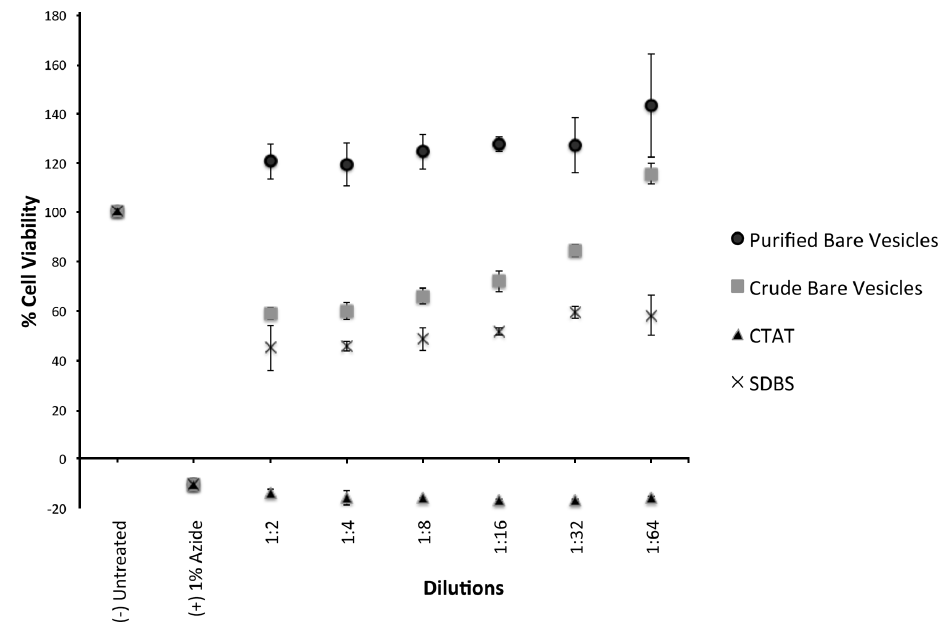
Figure 5. Cytotoxicity of CVs and components. Aliquots of vesicles or their components were incubated with THP-1 cells for 24 h and the viability assessed using an Alamar Blue assay from Biorad. 1% sodium azide was used as a killing control. The data were normalized to 100% of the reading obtained in the assay with untreated cells. All data points were assayed in triplicate. Error bars represent one standard deviation.